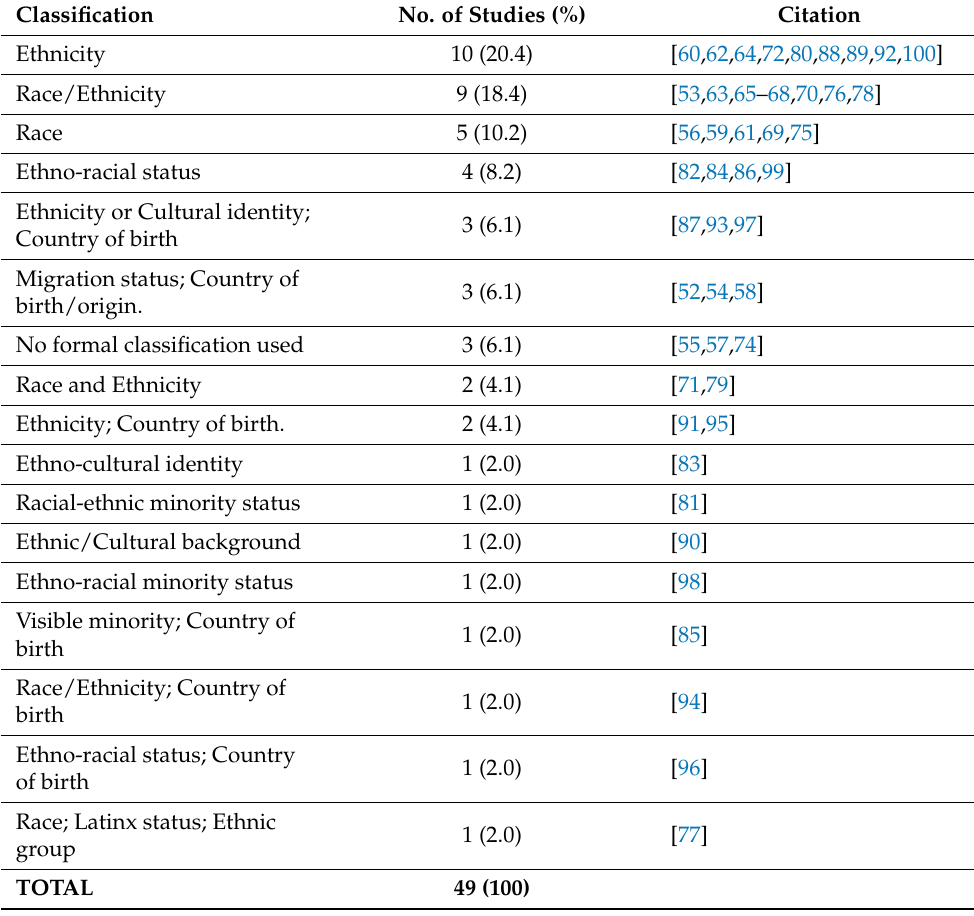
Table 6. Classification of cultural and linguistic diversity and related identities.